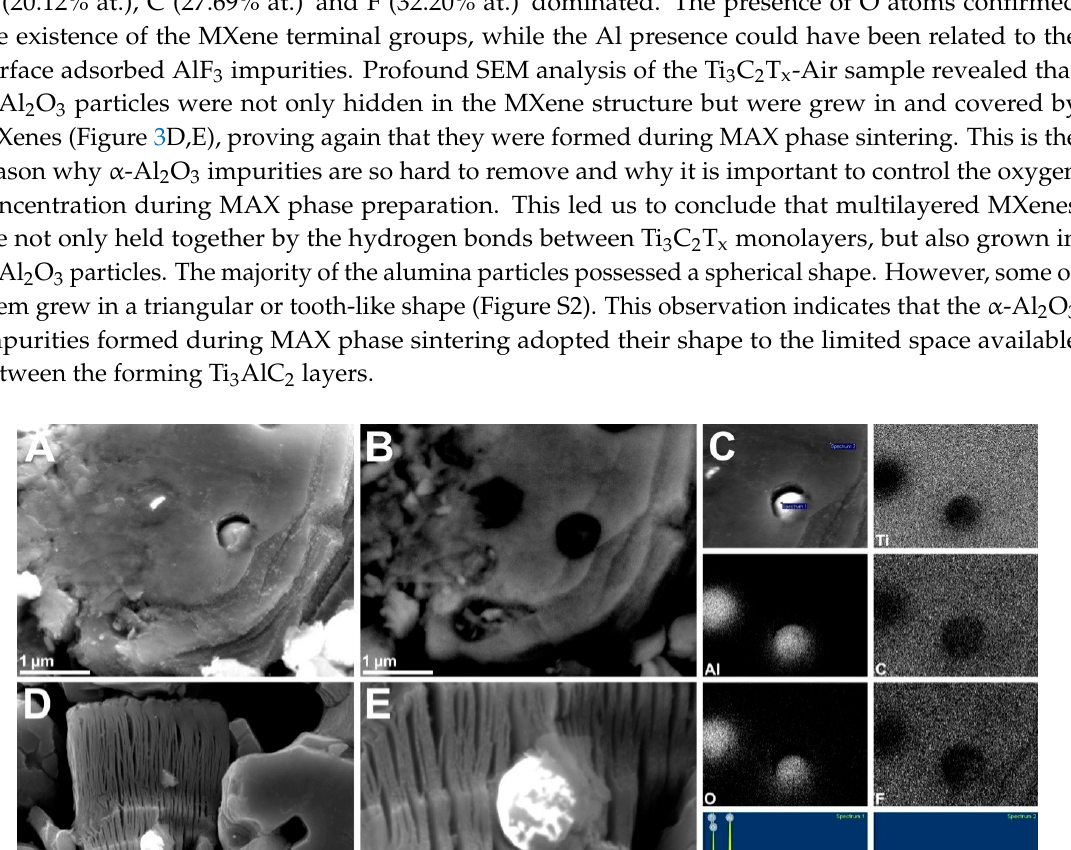
Figure 4. The N 2 adsorption isotherms of MAX phase and MXene powders.